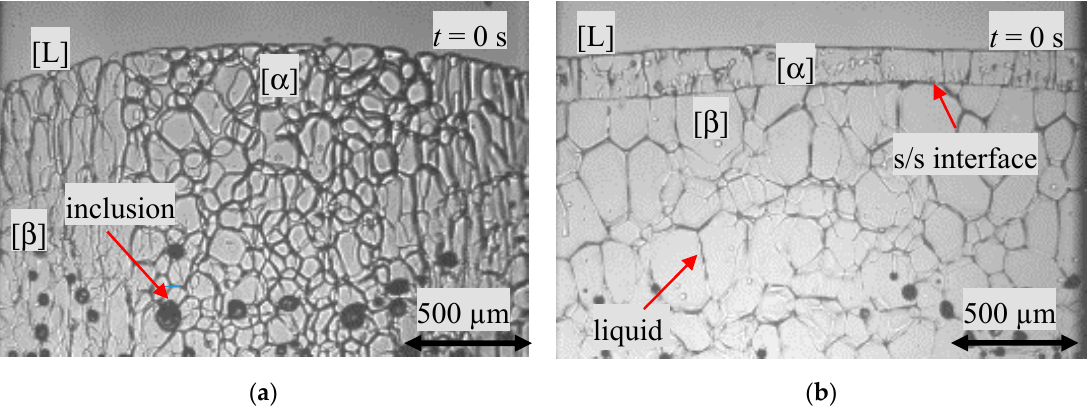
Figure 3. ( a ) Initial morphology of type A for a hypo-peritectic sample with x = 0.473 ± 0.0002 and ( b ) type B for a hyper-peritectic sample with x = 0.537 ± 0.0002 after 1 h in rest within the Bridgman-furnace. The black dots in both images are NPG-enriched liquid inclusions. In ( b ), two solid phases, seperated by a horizontal line, are recognizable. The images show a width of 2.000 μ m.